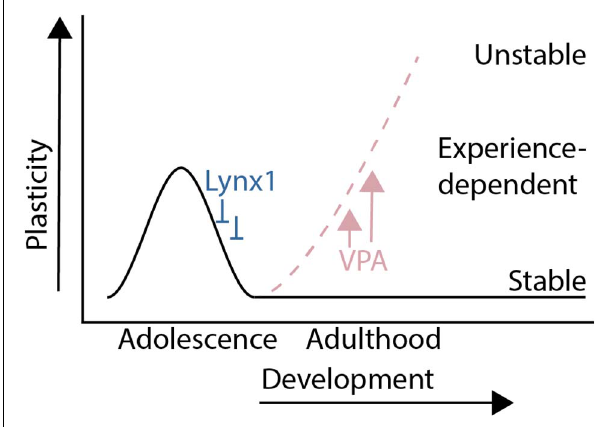
FIGURE 4 | Summary: A sensitive period for adolescent social dominance plasticity is regulated by cortical plasticity